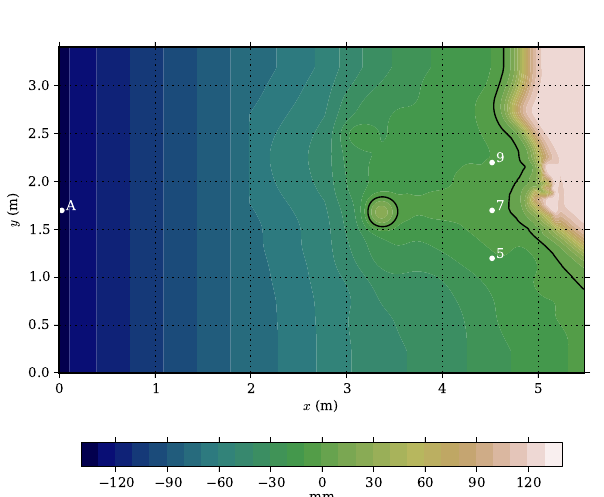
Fig. 16. Benchmark n. 4: topo-bathymetry used in the tank and po- sition of the probes numbered as 5, 7 and 9. The forcing is made by a plane wave with prescribed water elevation that was recorded by a gauge posed in position A. Isolines are given at 1cm interval. The black solid line is the coastline. Probes are in very shallow water at about or less than 1cm depth. The islet of Muen sits in front of the pocket beach of Monai, and influences the wave front.